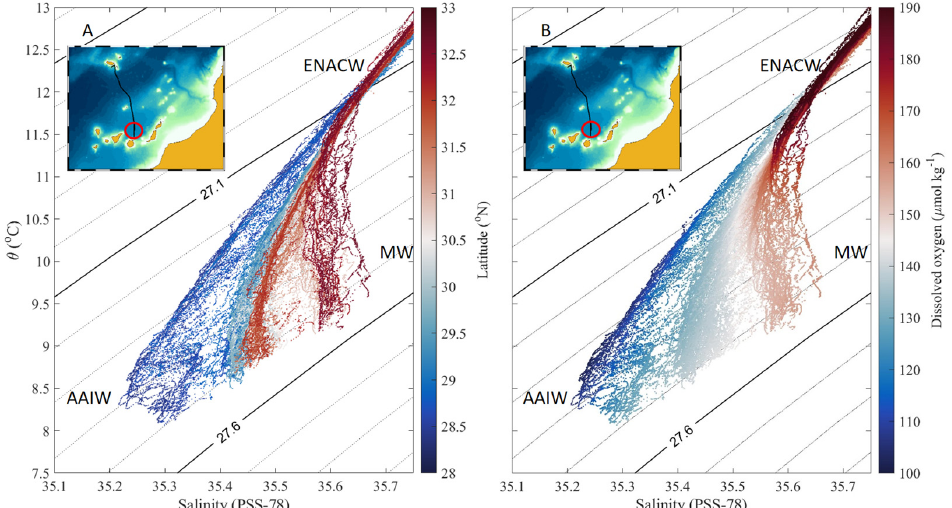
Figure 7. ( A ) θ –S plot of intermediate water column levels with colour scale corresponding to latitude. ( B ) θ –S plot of intermediate water column levels with colour scale corresponding to dissolved oxygen. Both images show a map with the section indicating with a red circle the location of the AAIW observations. Shown schematically is also the location of AAIW, MW and ENACW in the θ –S diagram.